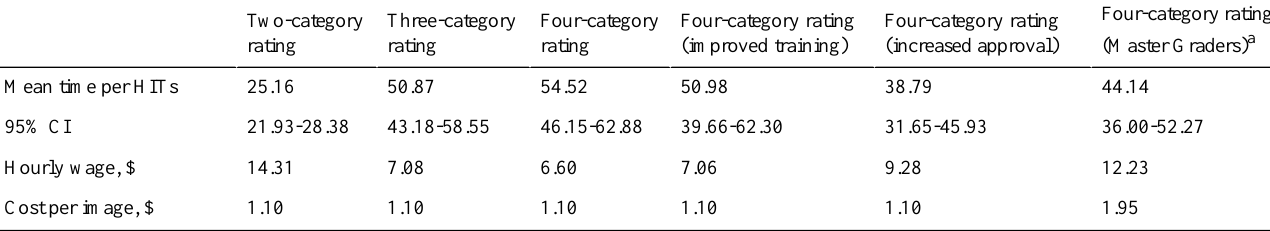
Table 2. Time to complete ratings (in